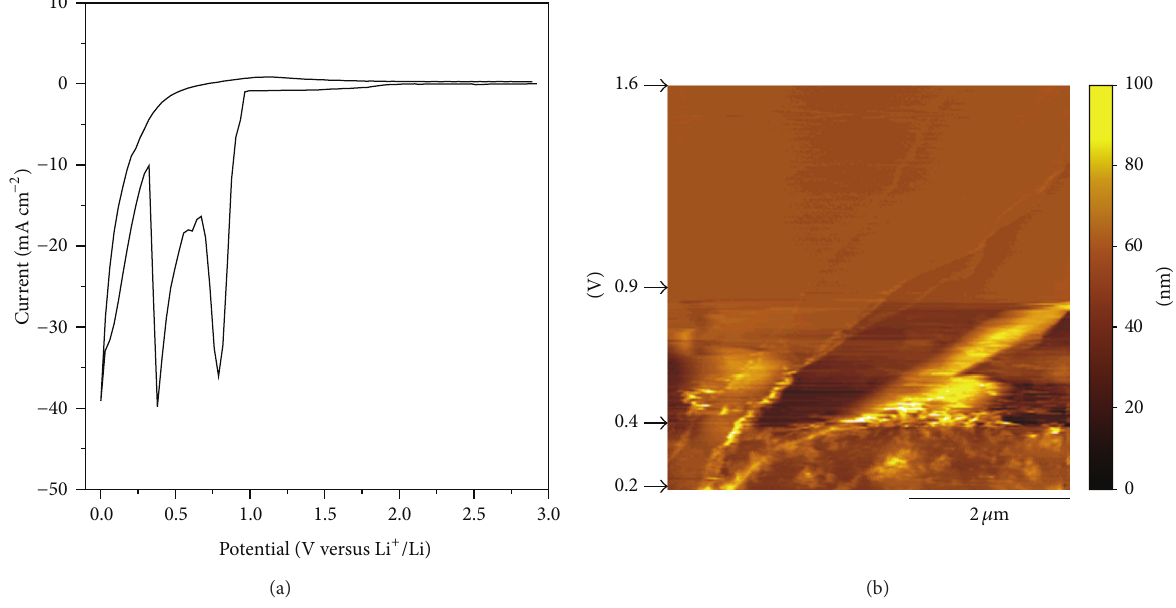
Figure 2: (a) The first cyclic voltammogram of the HOPG basal plane at 5mVs −1 in 1M LiClO 4 /EC + DEC and (b) in situ AFM image (5 × 5 𝜇 m 2 ) of the HOPG basal plane surface obtained at 2.9 V between 1.6 and 0.2 V in (a).